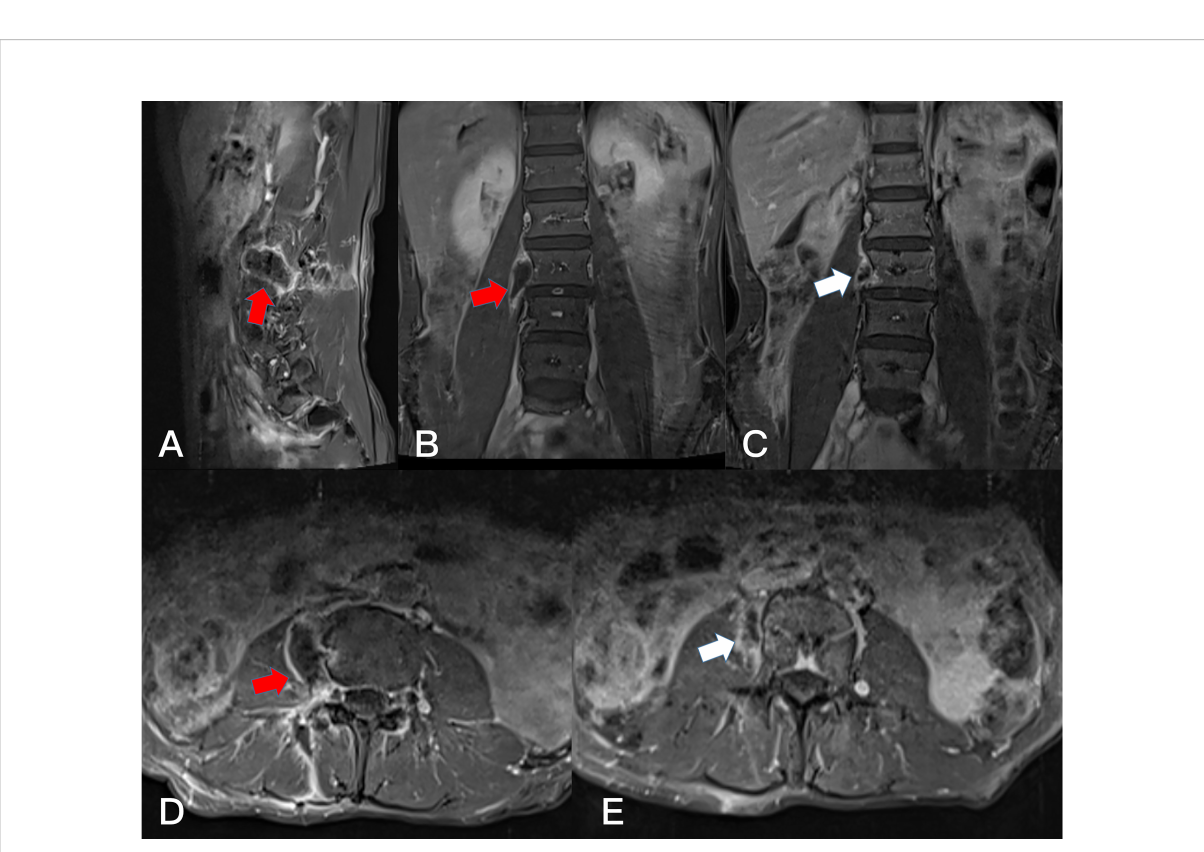
FIGURE 9 Postoperative T1-weighted enhanced MRI on sagittal (A) , coronal (B) , and axial (D) plane. Resection of the dumbbell tumor could not be identi fi ed after 1 month (arrows). Postoperative T1-weighted enhanced MRI on coronal (C) , and axial (E) plane. Resection of the dumbbell tumor could not be identi fi ed after 1 year